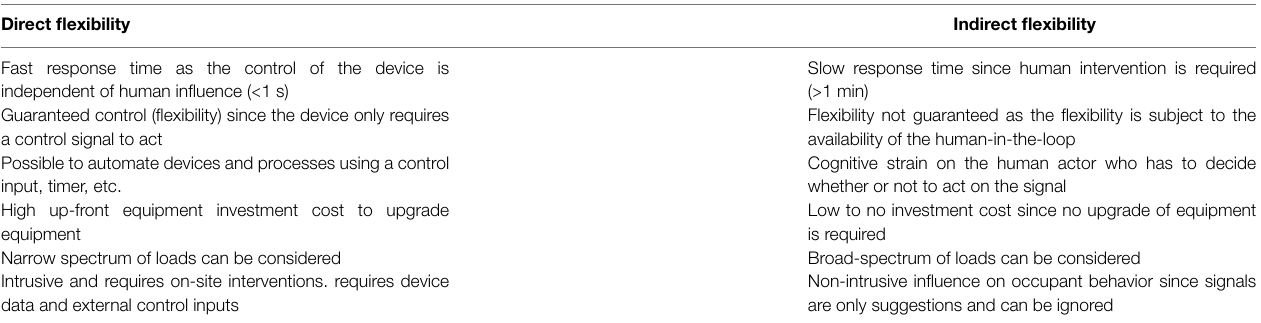
TABLE 1 | Comparison of direct and indirect flexibilities (Delinchant et al., 2020). Direct